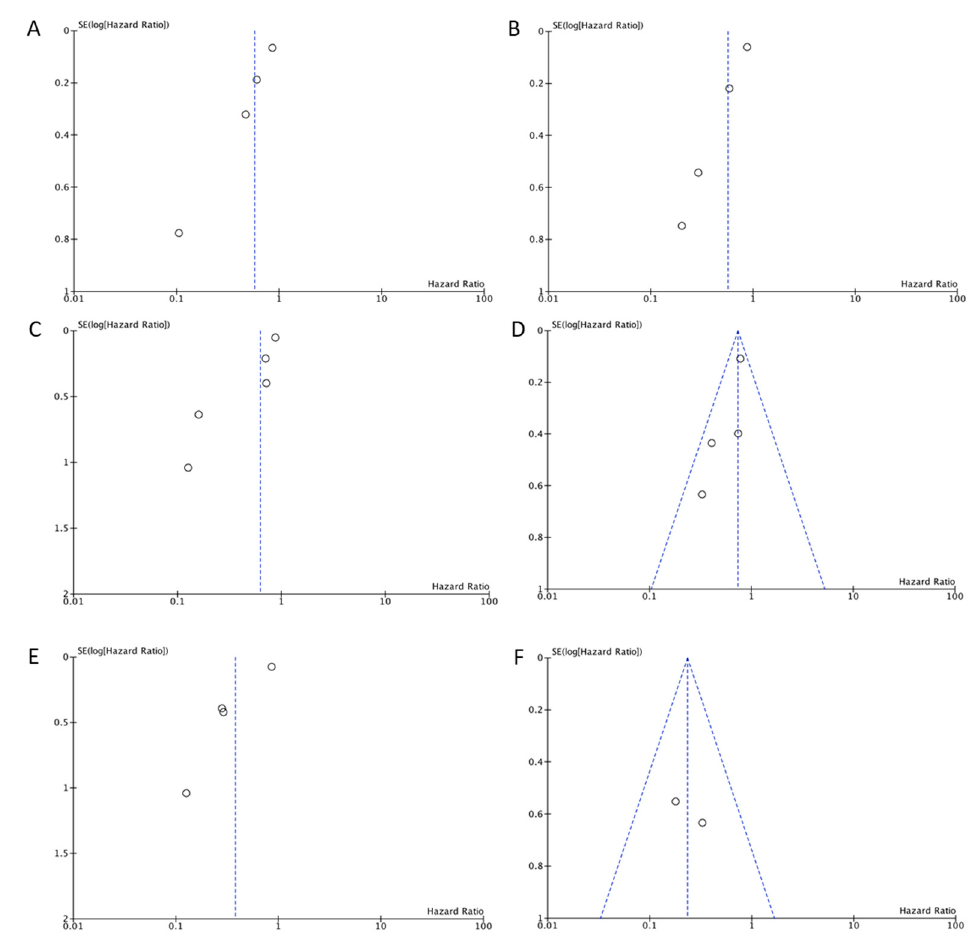
Figure 5. Funnel plot for assessment of potential publication bias in studies investigating the correlation between TIL infiltration evaluated in hematoxylin-eosin sections and the overall ( A ) and disease-free survival ( B ) of laryngeal cancer patients; the correlation between CD8+ TIL infiltration and the overall ( C ) and disease-free survival ( D ) of laryngeal cancer patients; and the correlation between CD3/CD4+ TIL infiltration and the overall ( E ) and disease-free survival ( F ) of laryngeal cancer patients.